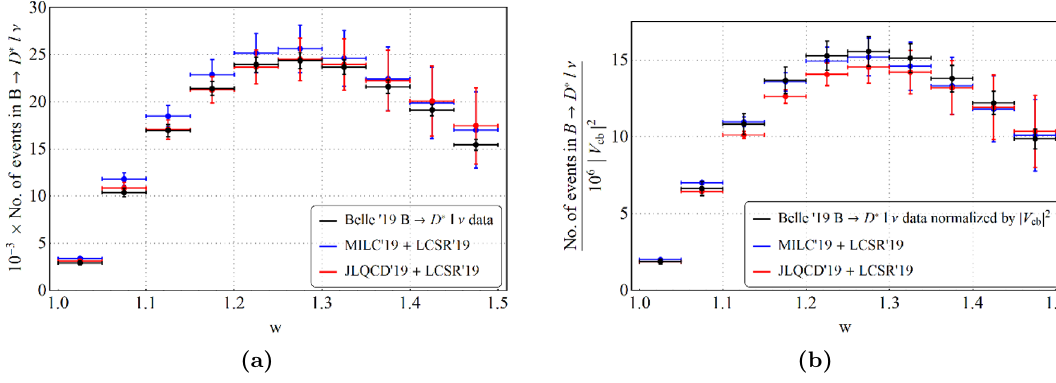
Figure 8. Comparison between the theory and experiment of the B ! D (cid:3) ‘(cid:23) ‘ decay distributions in w -bins (a) with and (b) without the normalization by j V cb j 2 . The black error-bars represent the latest experimental data from Belle [17]. In the case of theory, the form-factors are extracted using the preliminary inputs from table 11.